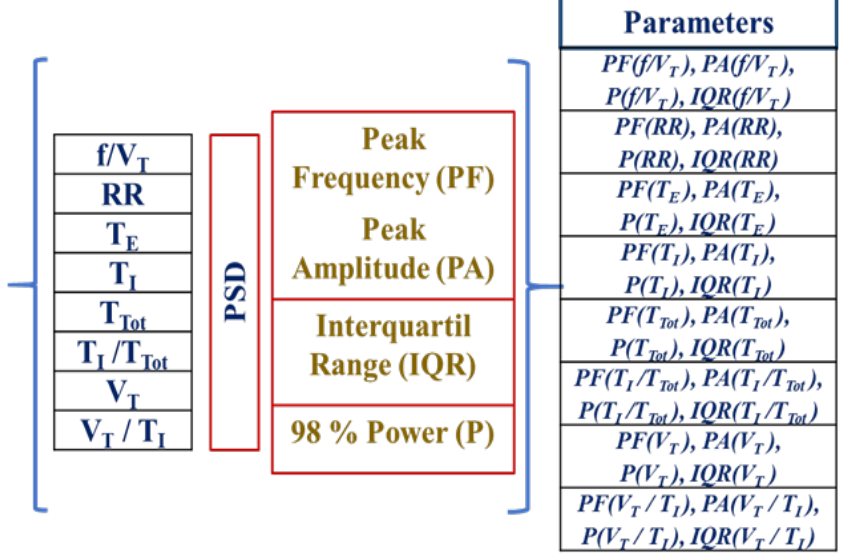
Figure 4. Schematic representation of the 32 variables extracted from the power spectral density for each of the 8 time series that describe the respiratory and cardiac pattern. T I : inspiratory time, T E : expiratory time, T Tot : duration of the respiratory cycle, V T : tidal volume, T I / T Tot : inspiratory fraction, V T / T I : mean inspired flow, f / V T : frequency–tidal volume ratio, where f is the respiratory rate; RR: cardiac beat-to-beat interval.